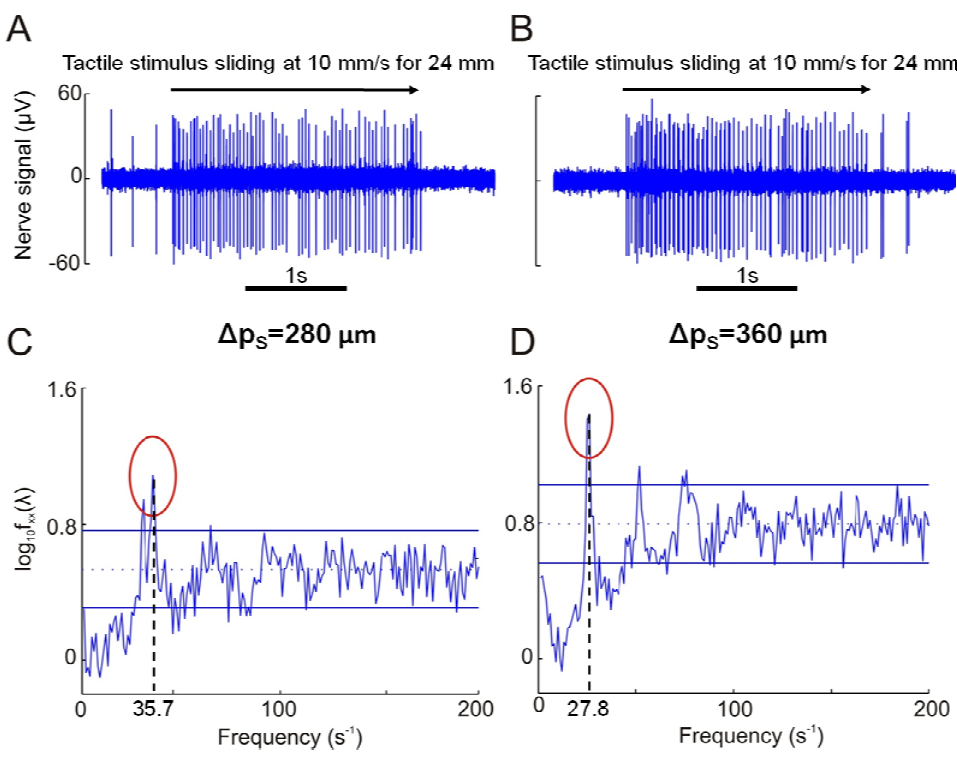
Figure 5. Panels A and B show microneurographic recordings from human single tactile RA afferents in the fingertips during stimulation as in Figures 1(C) and 3(A); a 10 mm/s sliding motion was applied across the distal phalanx. Panels C and D show spectral analysis of the nerve discharge trains from 12 repeated stimulus runs for the units shown in is 280 µm in A and C, 360 µm in B and D. A and B. Grating spatial periodicity Δ p s Principal frequencies resulting from Equation (1) according to the specific combination of grating spatial periodicity Δ p and sliding velocity v are 35.7 and 27.8 Hz for Panels C and D, s respectively, with meaningful coherence with the depicted experimental results. Horizontal lines in C and D show p < 0.01 confidence limits for significant frequency